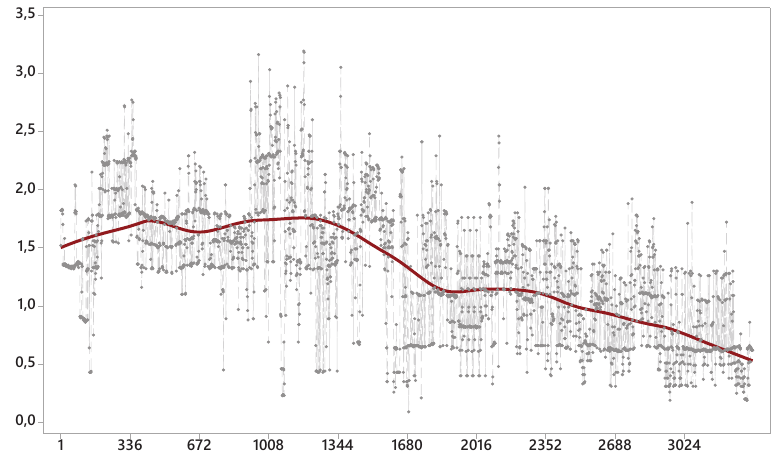
Fig. 4 Factor lowess plot f = 0 ,